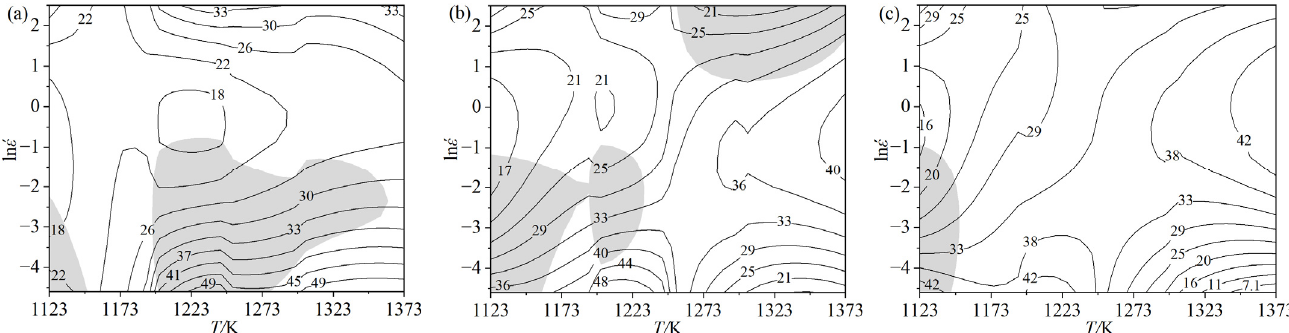
Figure 14. Thermal processing maps of Q345 under the different strains: ( a ) ɛ = 0.3; ( b ) ɛ = 0.5; ( c ) ɛ =